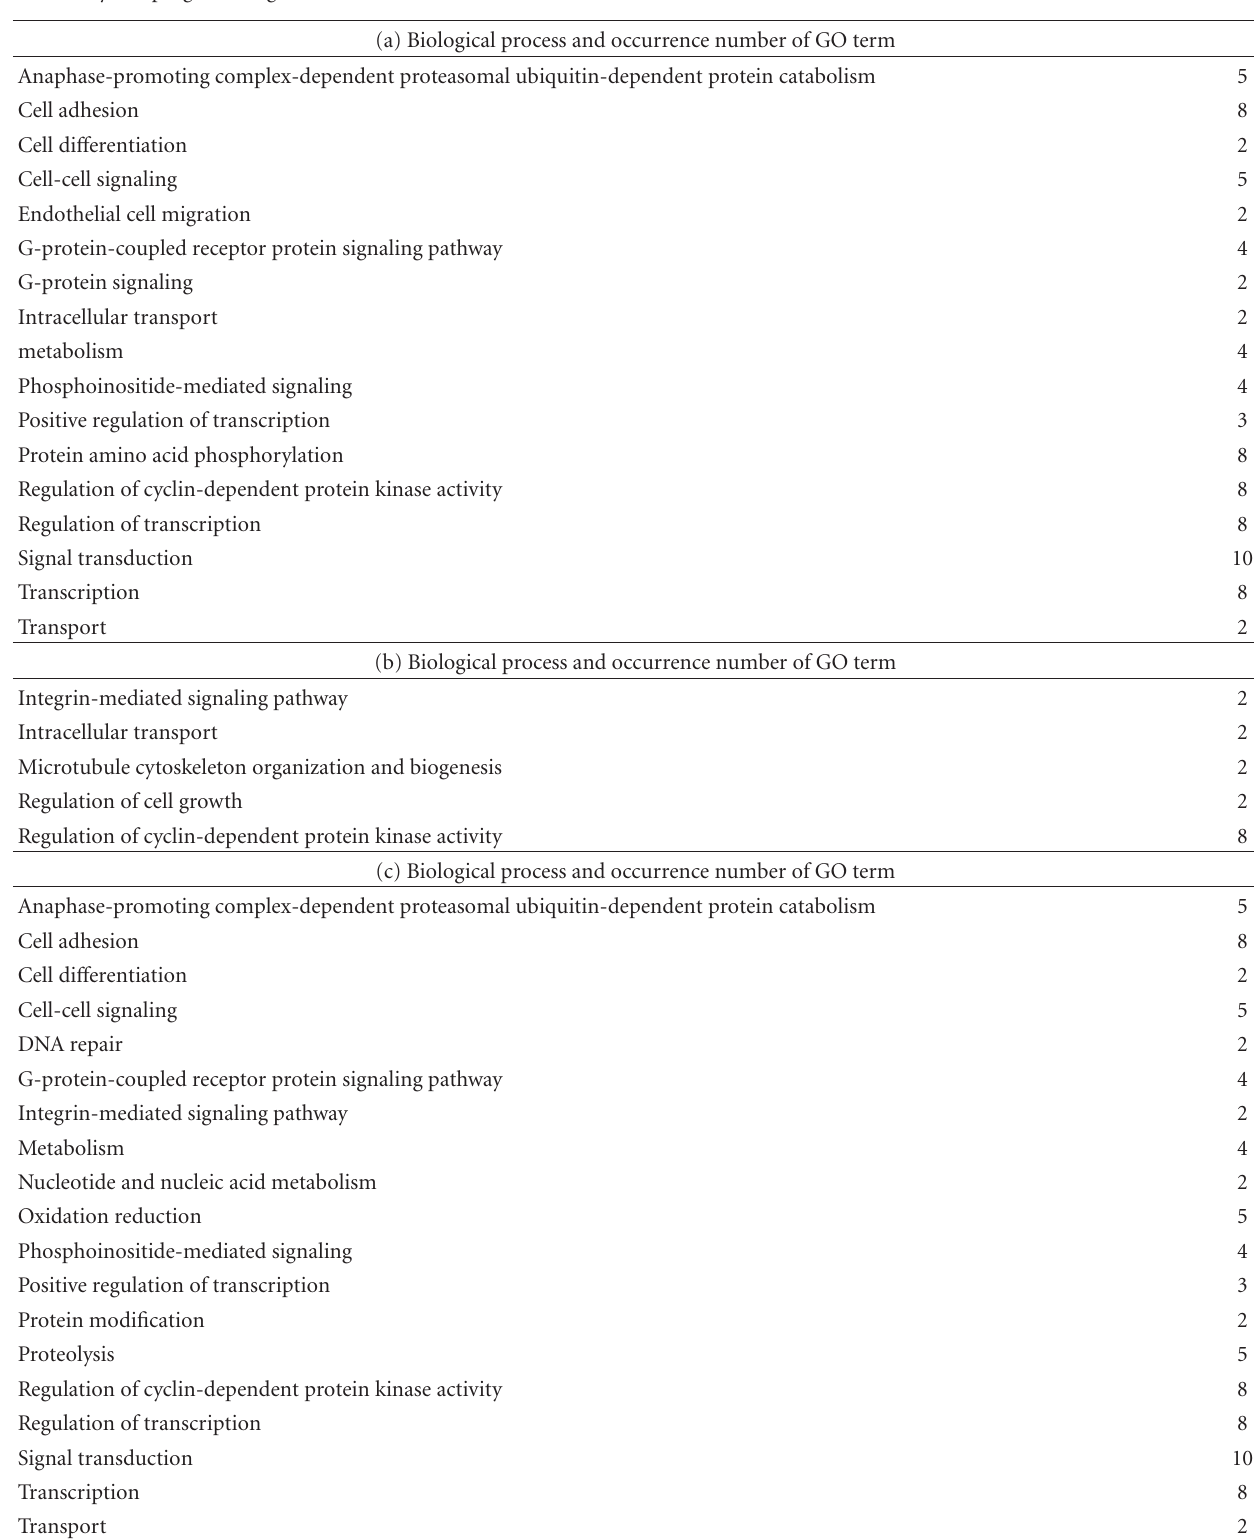
Table 1: (a) Biological processes and occurrence numbers of the same activated high expression (fold change ≥ 2) PTHLH feedback- mediated cell adhesion GO network in HCC compared with the corresponding low expression activated GO network of no-tumor hepatitis/cirrhotic tissues (HBV or HCV infection), (b) the di ff erent compared with the corresponding inhibited PTHLH feedback-mediated cell adhesion GO network of no-tumor hepatitis/cirrhotic tissues, and (c) the same compared with the corresponding inhibited GO network of HCC by our